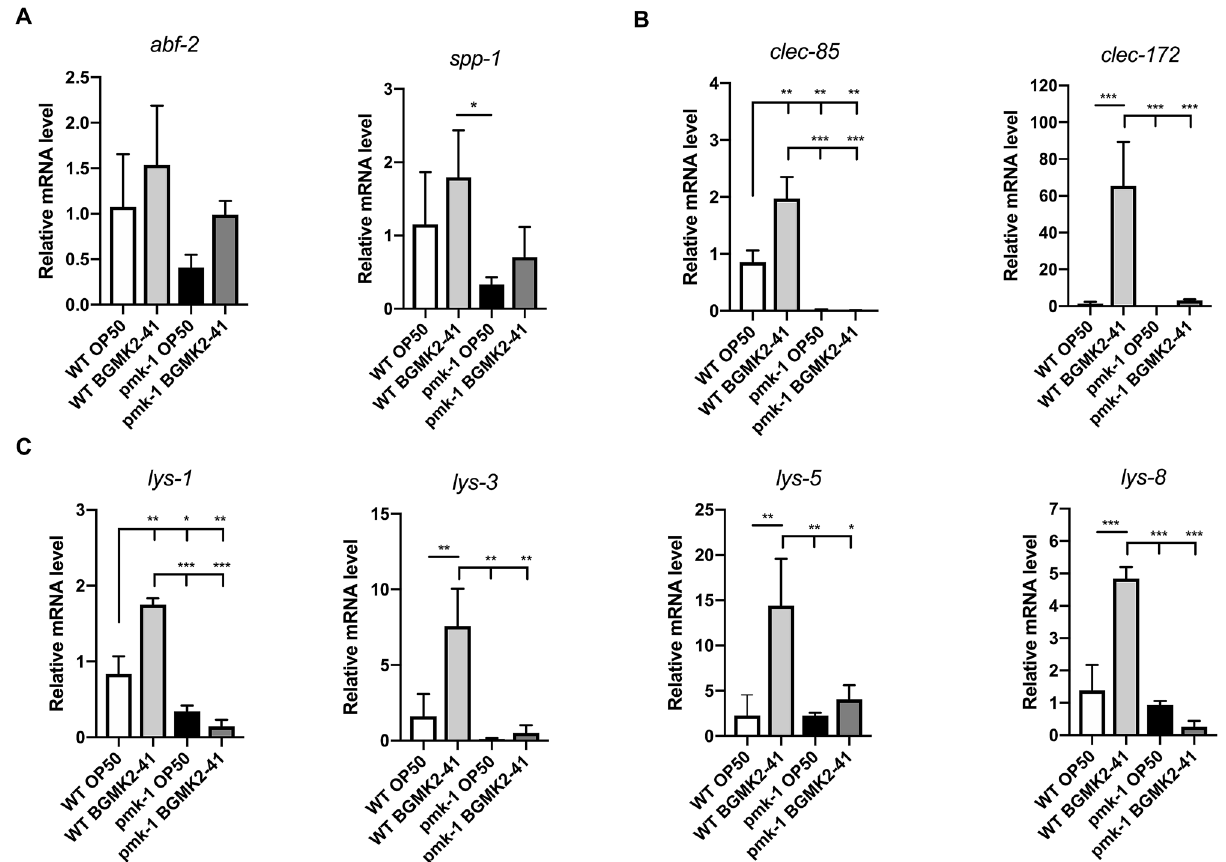
Figure 4. Heat-inactivated Lactobacillus curvatus BGMK2-41 controls the expression of antimicrobial proteins via p38 MAPK. Expression of ( A ) antimicrobial peptides, ( B ) C-type lectins and ( C ) lysozymes measured by qRT-PCR in day 1 old WT and pmk-1 worms treated with heat-inactivated BGMK2-41 (results from three independent experiments). All values are presented as mean ± SD. Student’s t-test was used to compare the treated group relative to control (* P < 0.05, ** P < 0.01, *** P < 0.001). The statistical analysis and graphs were done in GraphPad Prism version 8.0.0 for Mac, GraphPad Software, www. graph pad.